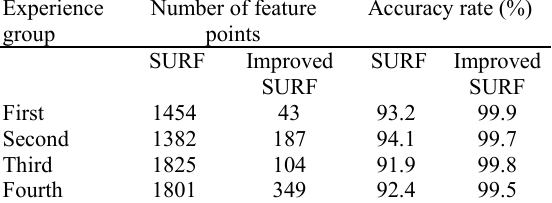
Table 1. Experimental comparison between SURF and Improved SURF algorithm